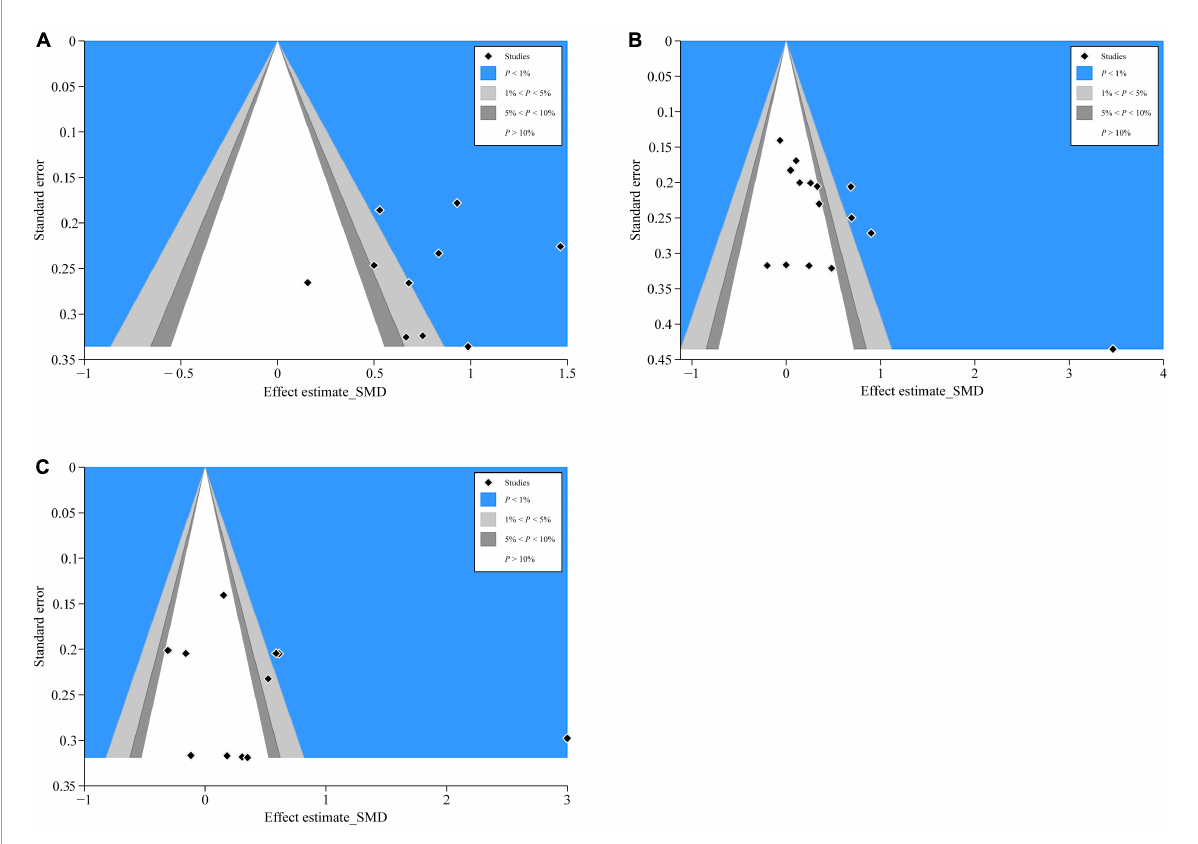
FIGURE8 Contour-enhanced funnel plots of CD4 + , ALB, and PA. (A) CD4 + ’s contour-enhanced funnel plot; (B) ALB’s contour-enhanced funnel plot; and (C) PA’s contour-enhanced funnel plot.